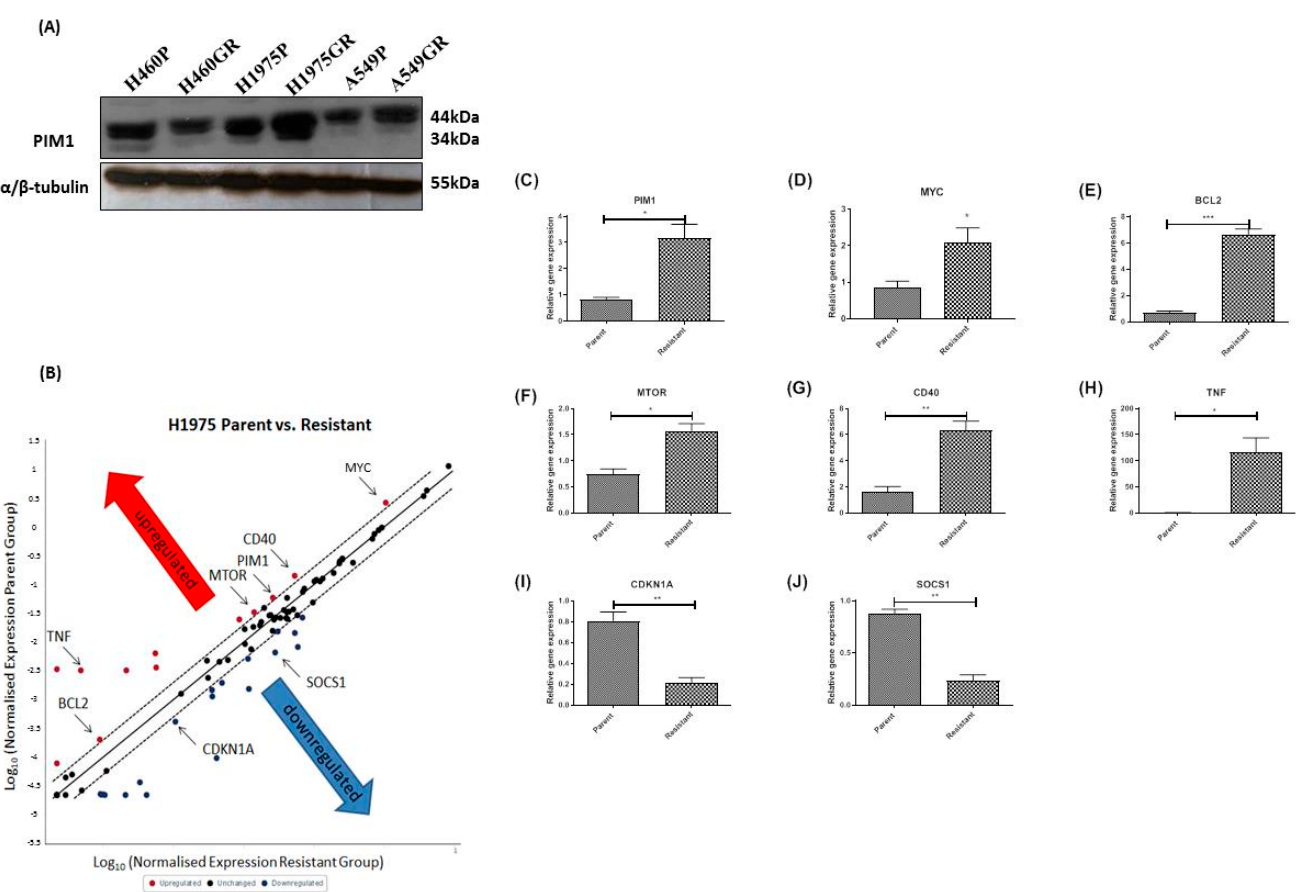
Figure 5. PIM1 expression in PI3K/mTOR inhibitor resistant cell line models and differential IL-6/STAT3 pathway signaling in H1975GR cells compared to H1975P cells. ( A ) Elevated PIM1 expression in H1975GR and A549GR cells by Western blot. Original Western blots in Figure S7. ( B ) The scatter plot compares normalized expression of every gene on the array between H1975GP and H1975GR. Twelve genes were upregulated (red dots) greater than two-fold and nineteen genes were downregulated (green dots) greater than two-fold in H1975GR. As indicated on the scatter plot, 8 genes altered by ≥ 2-fold in the array were chosen for further validation by SYBR-based real-time quantitative PCR. There was an upregulation of ( C ) PIM1 (3.84-fold, p < 0.05), ( D ) MYC (2.42-fold, p < 0.05), ( E ) anti-apoptotic BCL2 (9.23-fold, p < 0.001), ( F ) mTOR (2.10-fold, p < 0.05), ( G ) the TNF receptor co-stimulatory molecule CD40 (3.94-fold, p < 0.01) and ( H ) TNF (>100-fold, p < 0.05). In contrast there was a downregulation of ( I ) CDKN1A ( − 3.82-fold, p < 0.01) and ( J ) SOCS1 ( − 3.67-fold, p < 0.01). * p < 0.05, ** p < 0.01, *** p < 0.001, paired student t-test, n = 4.